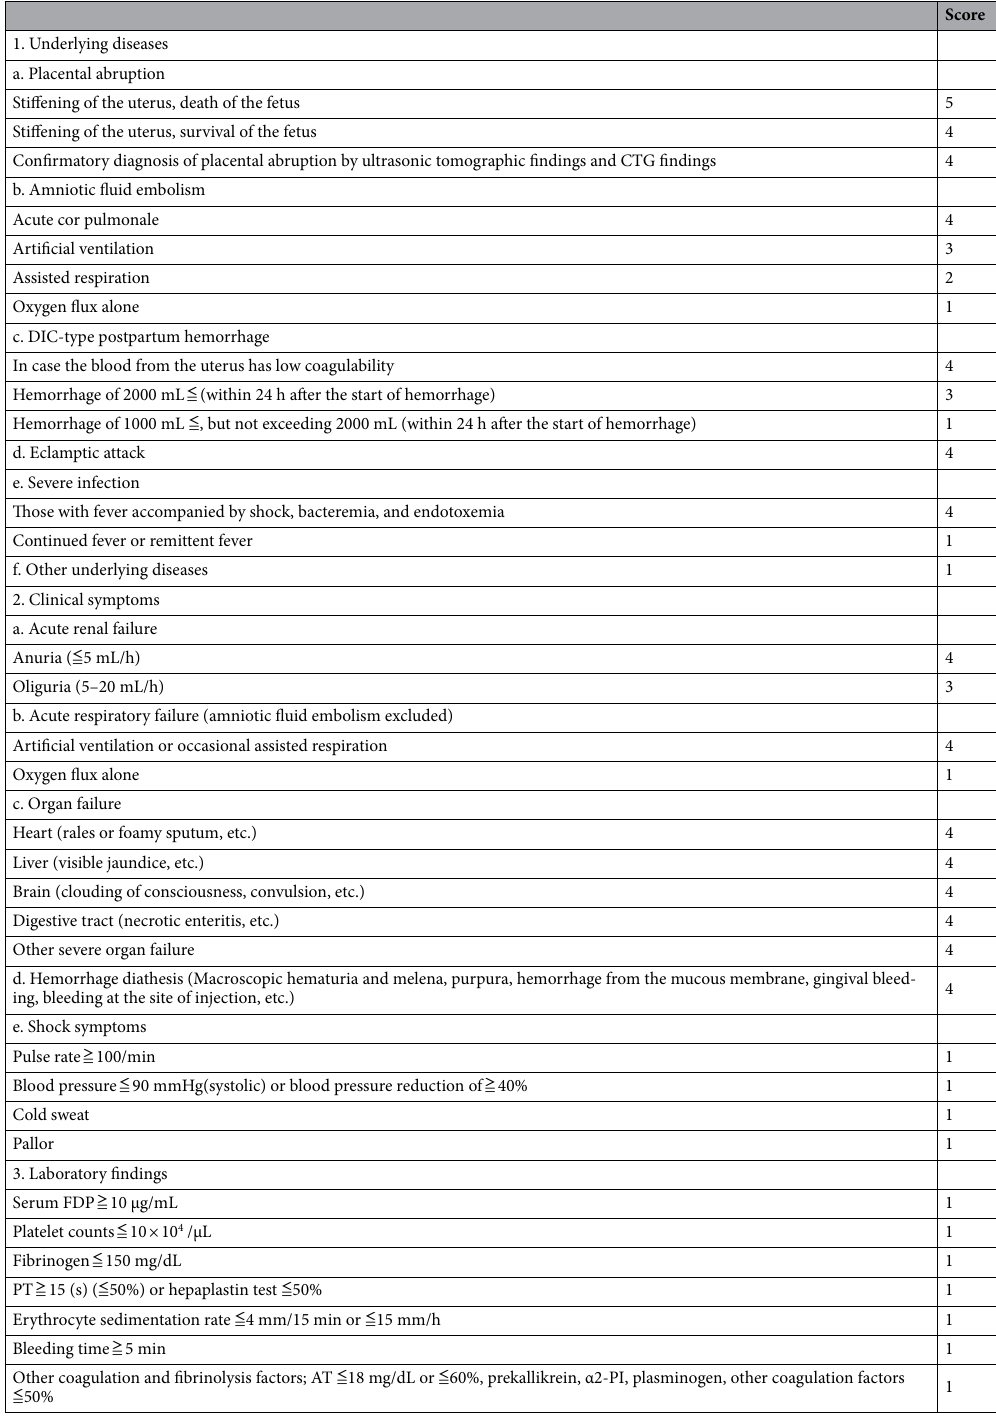
Table 4. DIC diagnostic criteria in obstetrics. CTG, cardiotocogram; DIC, disseminated intravascular coagulation; FDP, fibrinogen and fibrin degradation; PT, prothrombin time; AT,